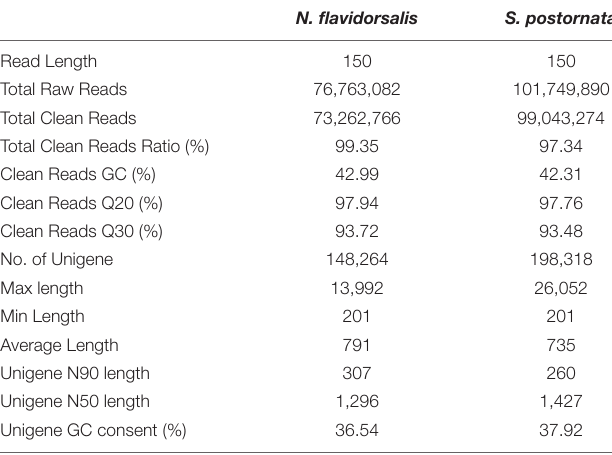
TABLE 5 | An overview of the sequencing and assembly process (after trinity).